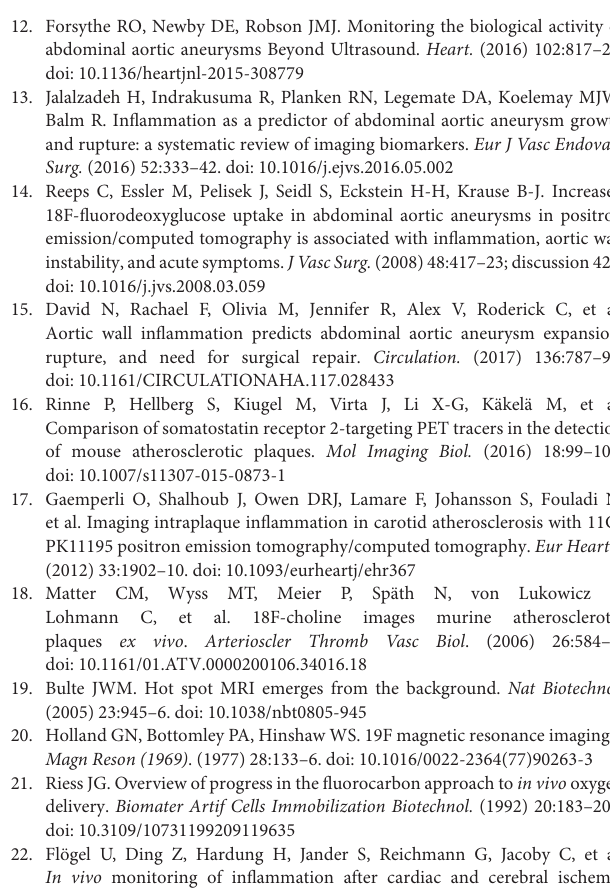
Supplementary Figure 1 | Schematic overview. Schematic overview of experimental series for the imaging of angII-induced AAA/AAD formation in apoE − / − mice. First a basal MRI characterization was conducted before implantation of the osmotic minipumps. PFCs were intravenously injected on day 0, 2, and 4 after minipump implantation. 1 H/ 19 F MRI was conducted on day 2, 4, 7, and 10. Finally, the animals were sacrificed, the aorta excised and subjected to flow cytometry, ex vivo 1 H/ 19 F MRI and/or histology. Schematic drawing of the mouse was derived from: https://smart.servier.com/. Supplementary Movie 1 | Blood flow in abdominal aortic dissections and aneurysms. Sagittal 1 H cine FISP movies to visualize the blood flow in AADs (left) and AAAs (middle). Right: Sagittal 1 H black blood movie. Note the turbulent flow that is visible in the AAA area of both the bright and black blood movie. Supplementary Movie 2 | Spatial distribution of the 19 F signal in AAD. 3D reconstruction of a segmented high resolution 1 H/ 19 F MRI scan of an excised, fixed, and embedded aorta with aortic dissection. Gray, external area of the vessel; green, lumen of the vessel; “hot-iron”, 19 F